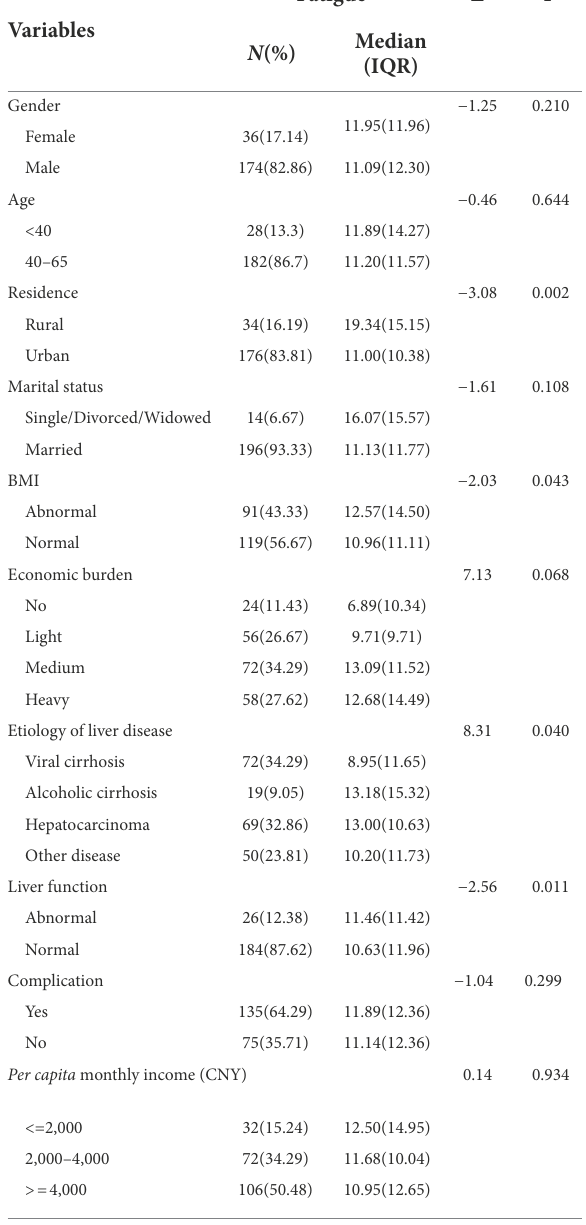
TABLE 1 Demographic and clinical characteristics by fatigue and results of the univariate.